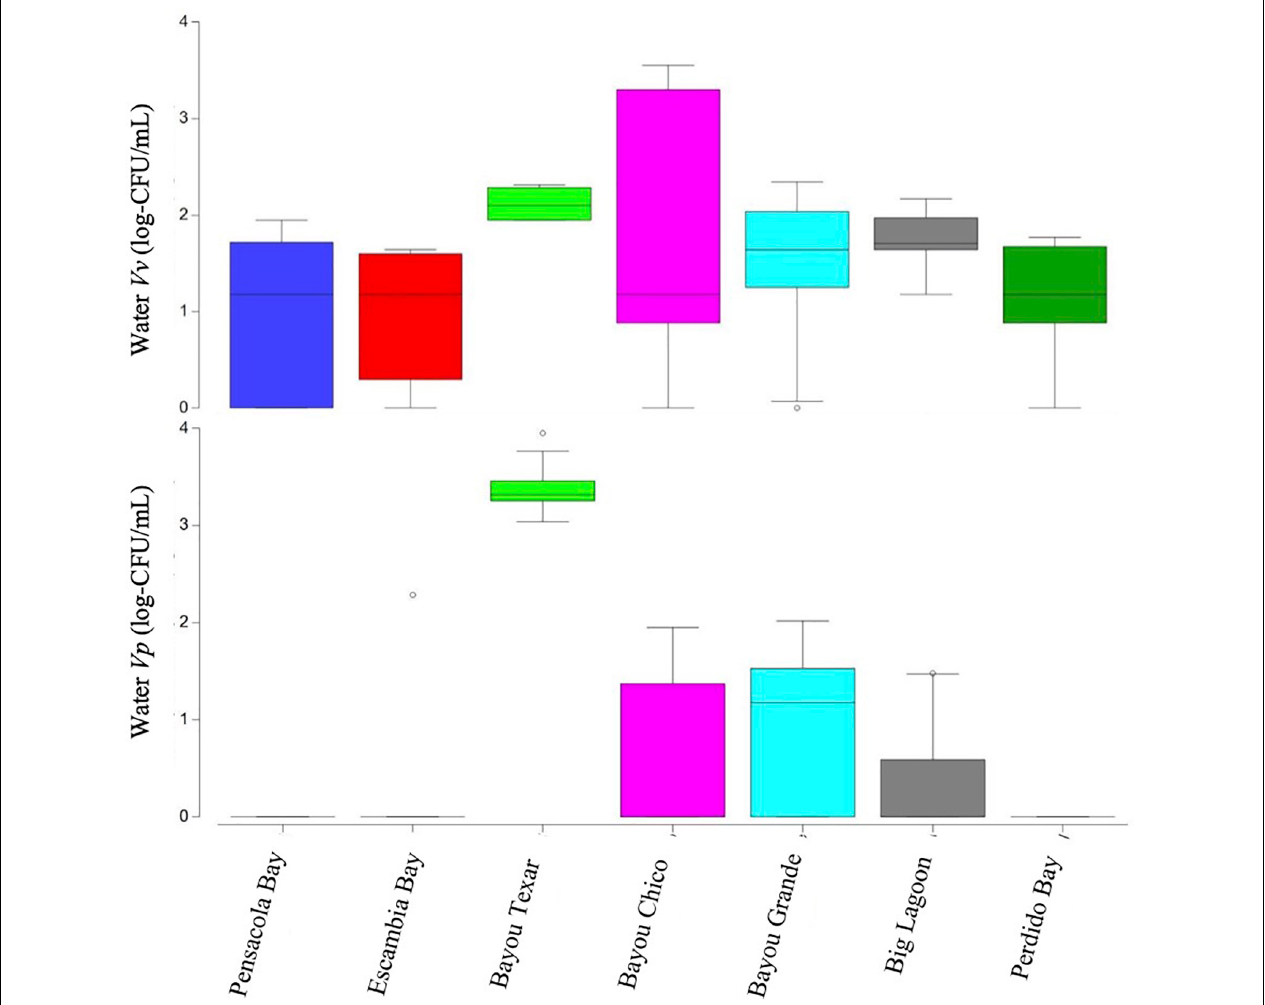
FIGURE 3 | Boxplots of surface water Vibrio abundances. Open circles denote extreme values; box-tops and -bottoms show the 25th and 75th percentiles; lines within boxes mark mean values; and whiskers indicate minimums and